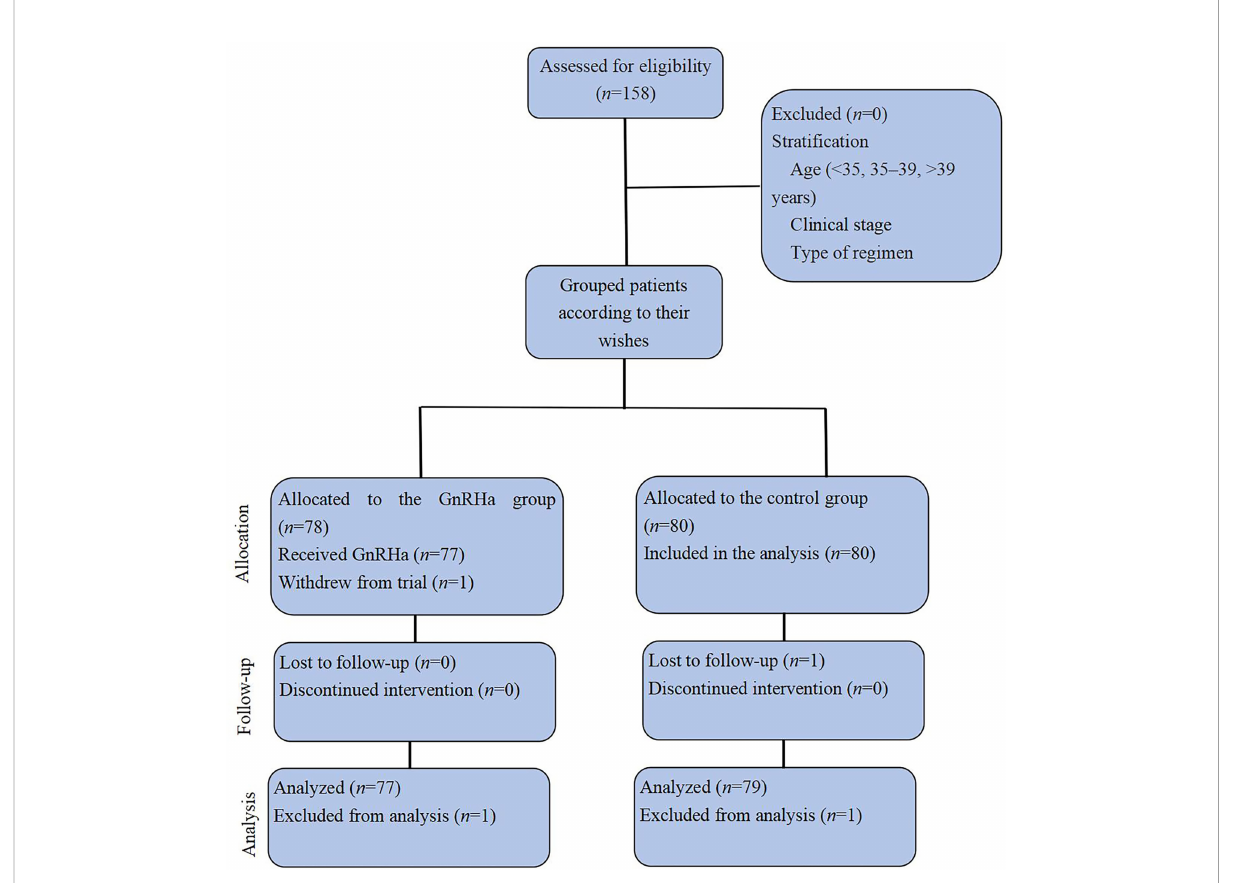
FIGURE 1 CONSORT diagram. GnRHa, gonadotropin-releasing hormone